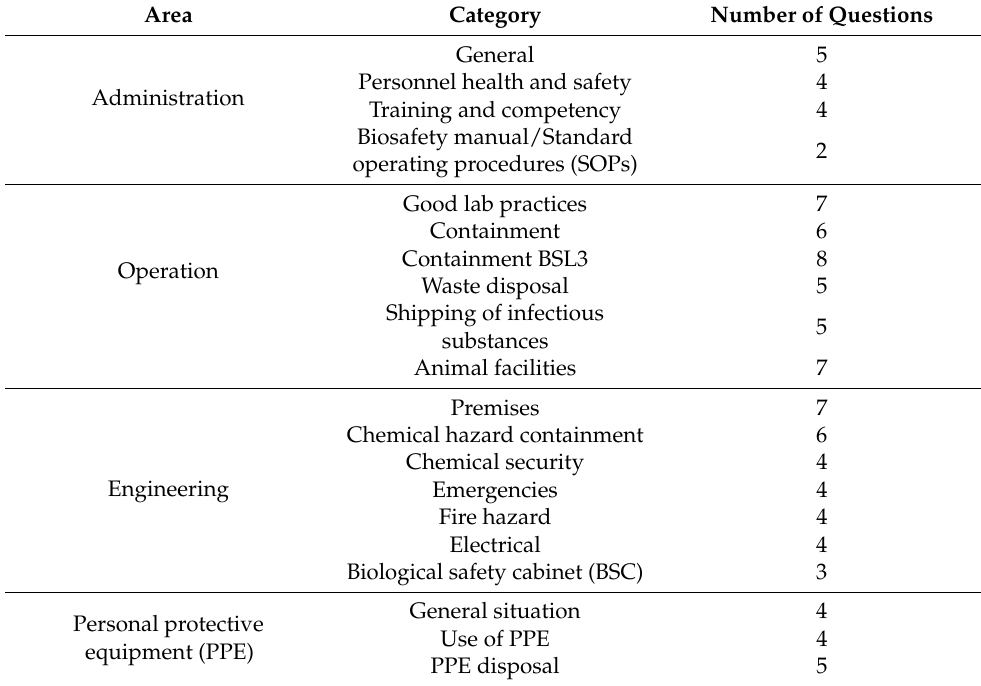
Table 1. Area, categories, and number of questions per category for the FAO laboratory mapping